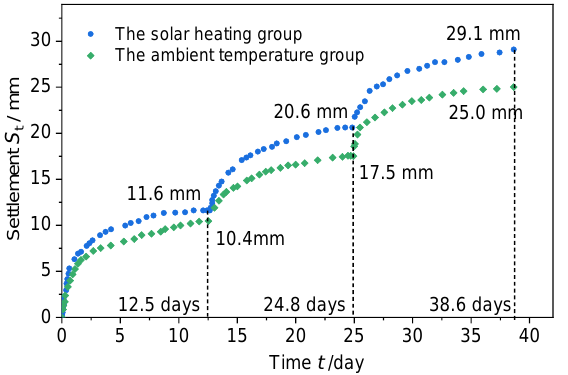
Figure 9. Settlement with time.